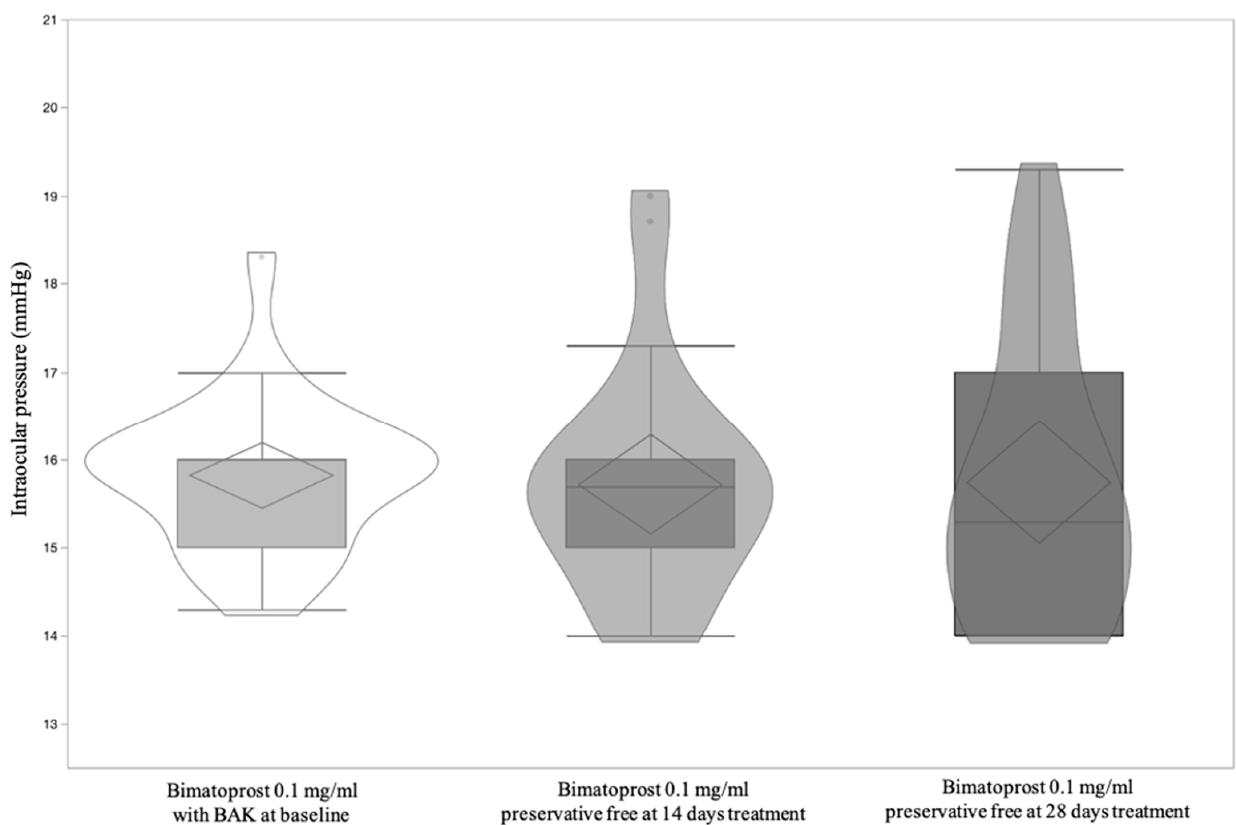
Figure 3. Violin and box-plots of fluorescein tear break-up time by Bimatoprost 0.1 mg/mL with BAK at baseline and Bimatoprost 0.1 mg/mL preservative-free at 14 and 28 days.